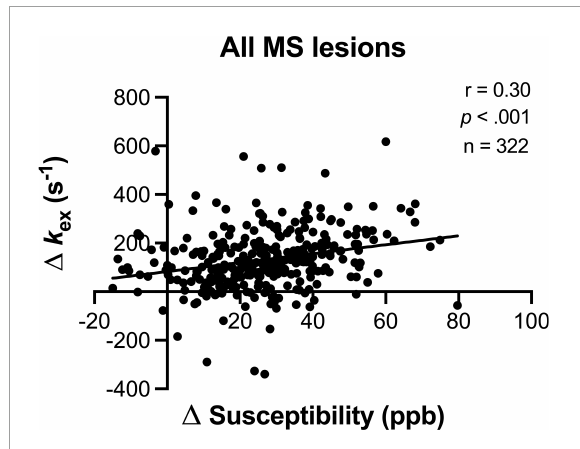
FIGURE1 The lesion k ex elevation increased with susceptibility elevation. Note that a few lesions that showed negative (cid:49) k ex were